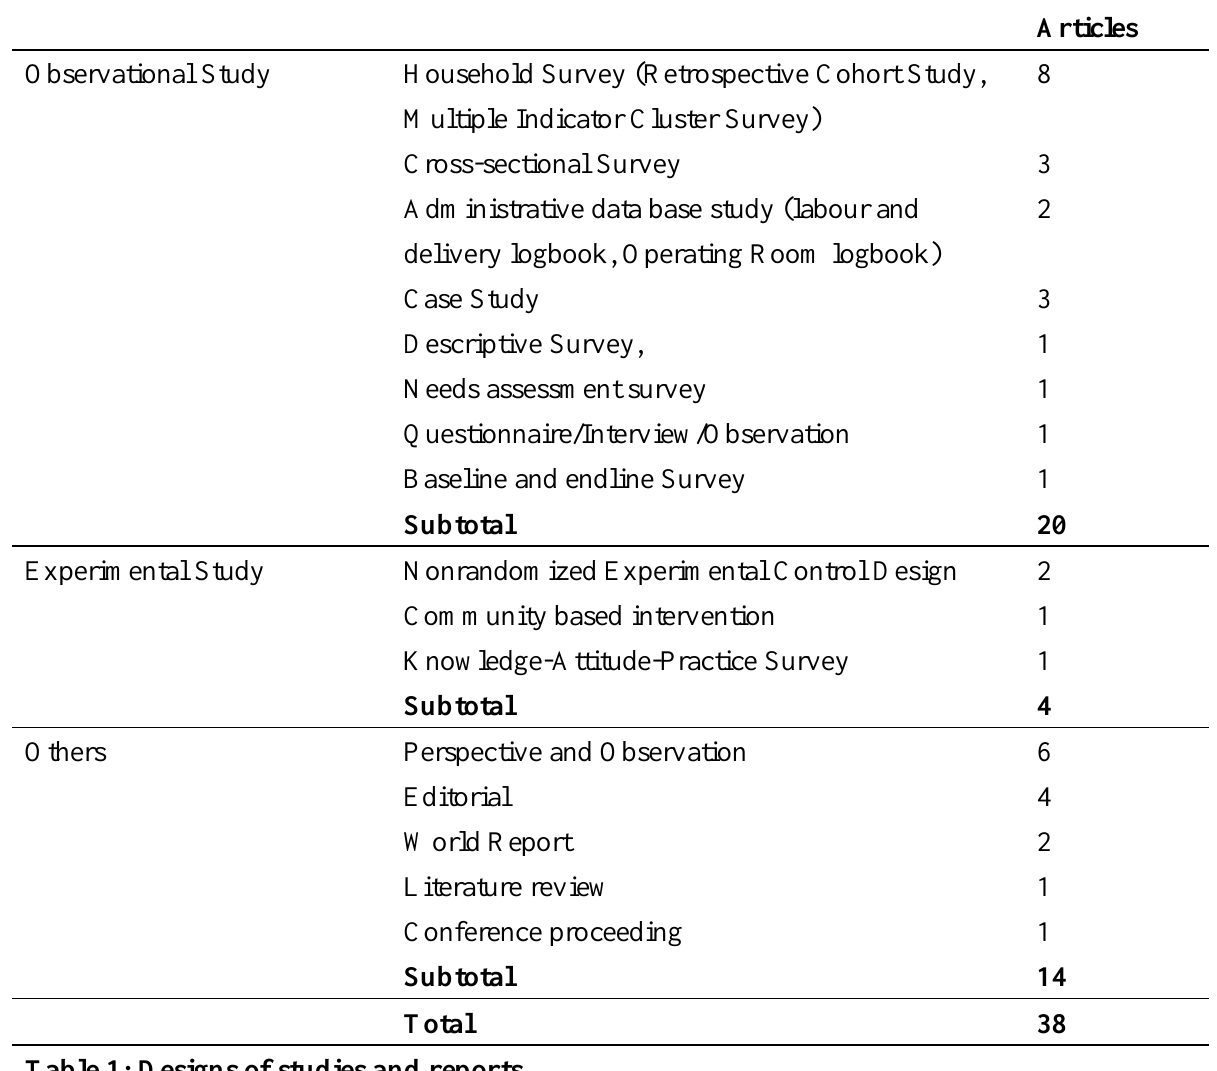
Table 1: Designs of studies and